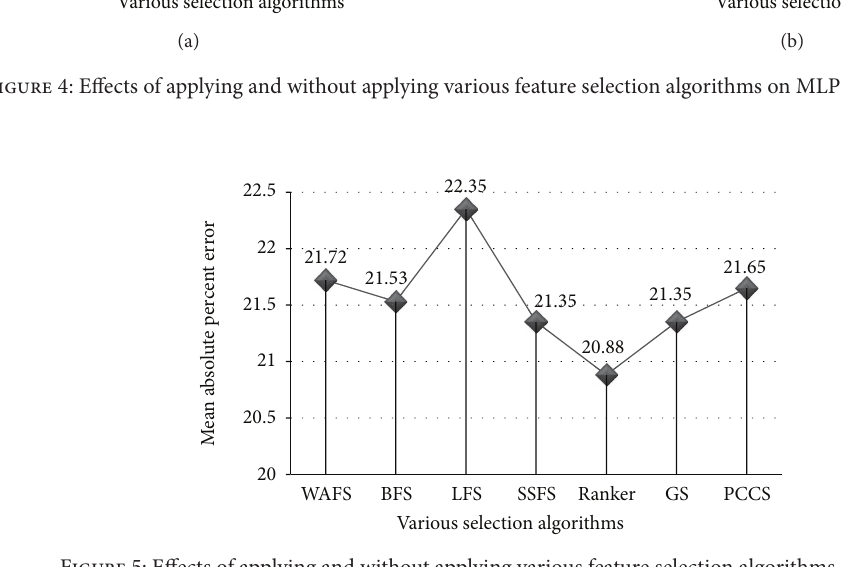
Figure 5: Effects of applying and without applying various feature selection algorithms on